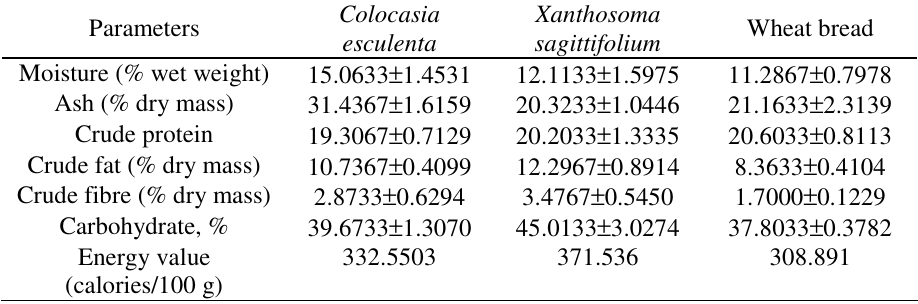
Table 7. Mean proximate composition of the bread